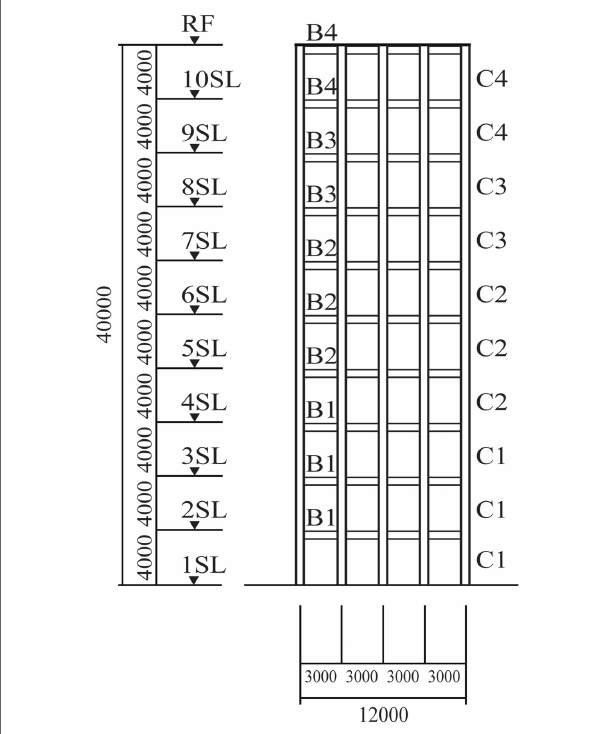
FIGURE 6 | 10-story building